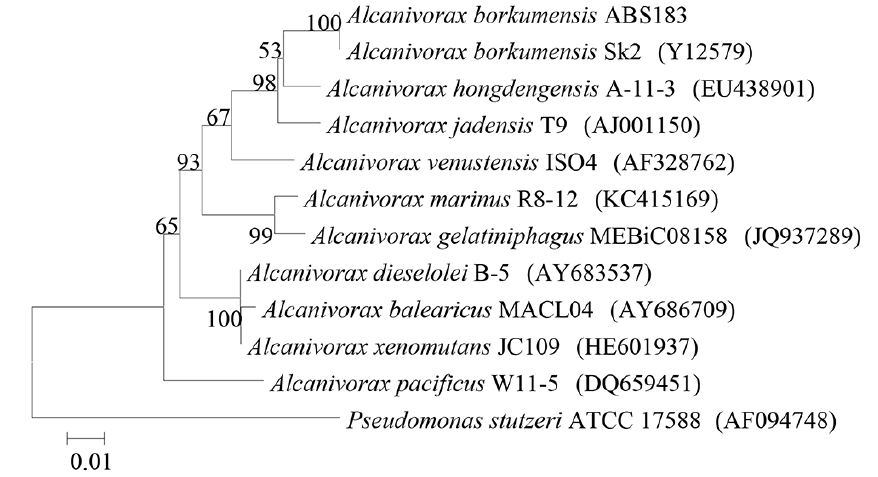
Figure 5. Phylogenetic tree of 16S rRNA genes. Bootstrap values (expressed as percentages of 1000 replications) are shown at the branches of the neighbor-joining